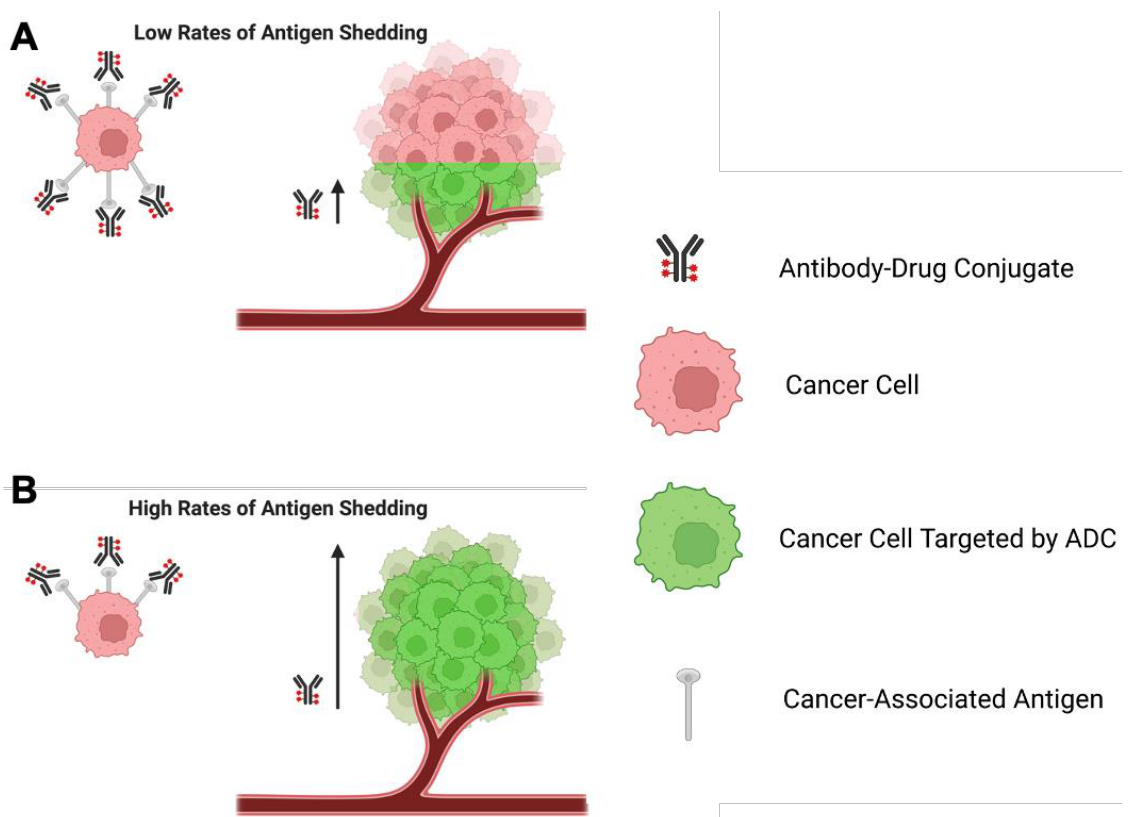
Figure 4. Schematic representation of the proposed effect of antigen shedding on the binding-site barrier and ADC effectiveness. ( A ) When rates of antigen shedding are low, a greater number of cell surface antigens per cancer cell are available which serve as a ‘binding-site barrier’, depleting the supply of ADC molecules entering the tumour microenvironment close to the vasculature. ( B ) When rates of antigen shedding are high, a smaller number of cell surface antigens per cancer cell are available, meaning that fewer ADCs bind to each cancer cell and a greater number of ADC molecules are available to bind to more cancer cells distant from the vasculature. Created with Bioren- der.com.